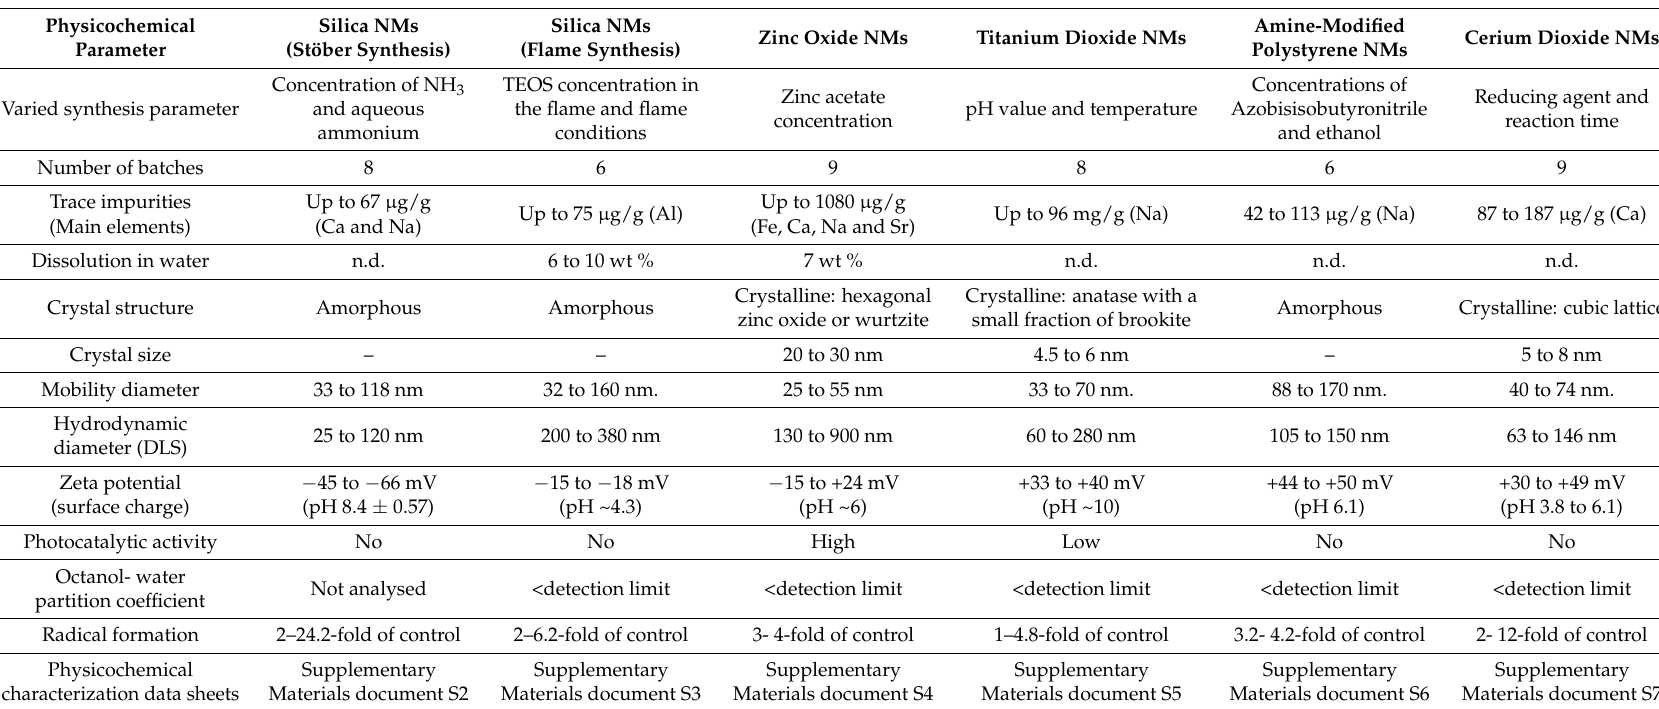
Table 2. Summarized physicochemical parameters characterized for the five selected priority nanomaterials (NMs), highlighting the B2B variability. Physicochemical